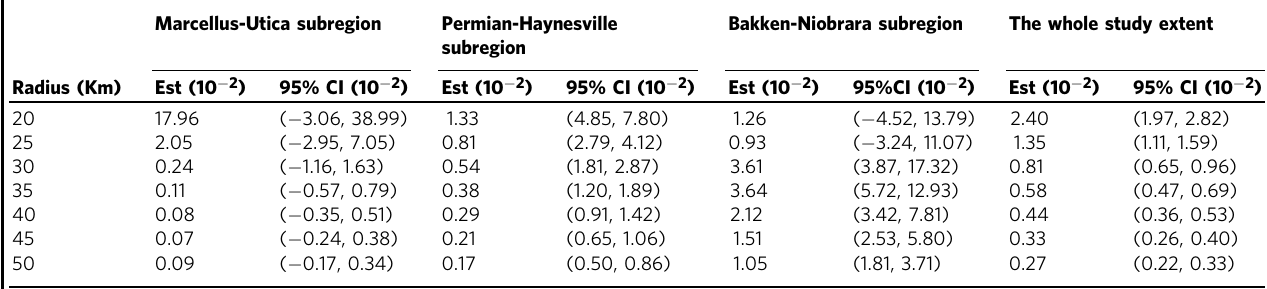
Table 3 The associations between PR and upwind UOGD well count in three subregions of our study